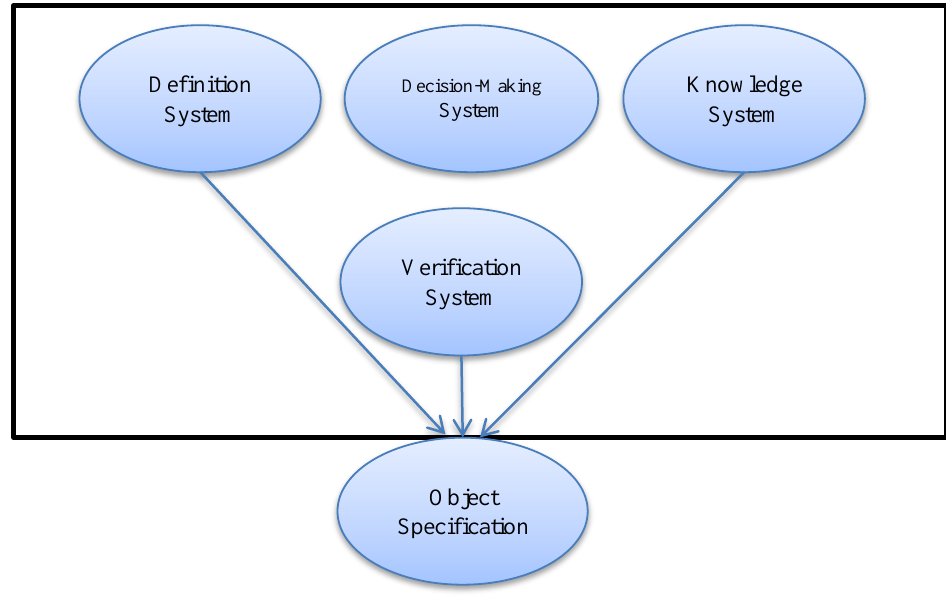
Figure 3. Design Structure